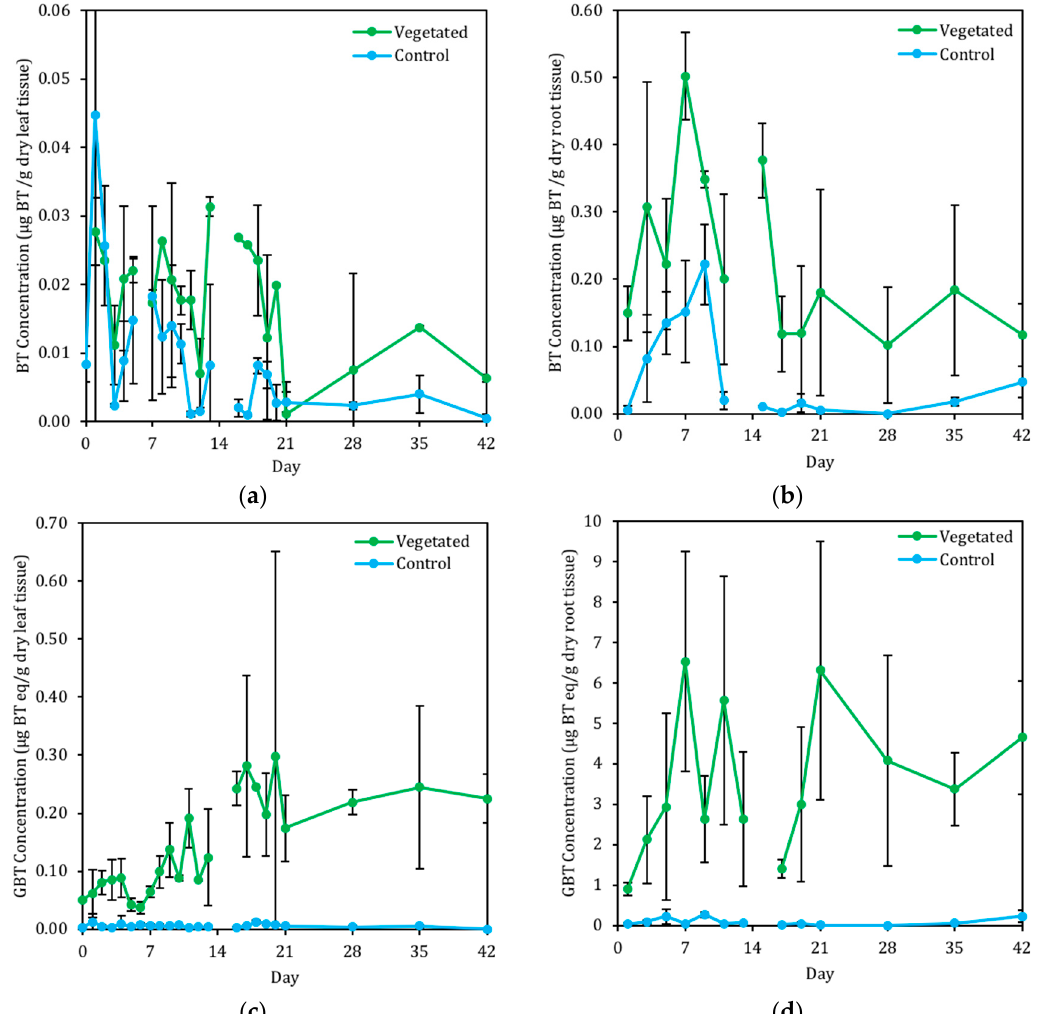
Figure 6. Mean concentration of BT in C. praegracilis leaf ( a ) and root ( b ) tissue in vegetated biofilter mesocosms exposed to BT (green) and control (blue) biofilter mesocosms. Mean concentration of GBT, in BT equivalents, in C. praegracilis leaf ( c ) and root ( d ) tissue in vegetated biofilter mesocosms exposed to BT (green) and control (blue) biofilter mesocosms. Storm events occurred on days 0, 7, and 14. Error bars represent one standard deviation ( n = 3). Note that tissue samples for days 14, 15, and 16 were visually contaminated with mold and therefore omitted.